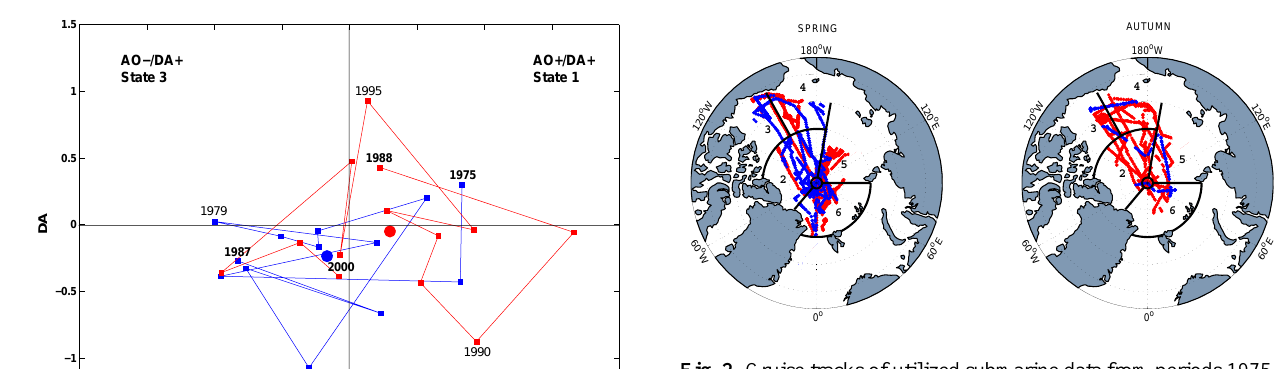
Fig. 2. Cruise tracks of utilized submarine data from periods 1975– 1987 (blue) and 1988–2000 (red) in Spring (on the left) and Autumn (on the right). The whole study area is divided into 6 regions: 1. North Pole, 2. Canada Basin, 3. Beaufort Sea, 4. Chukchi Sea, 5. Eastern Arctic and 6. Nansen Basin. Table 1. Length of the submarine track in